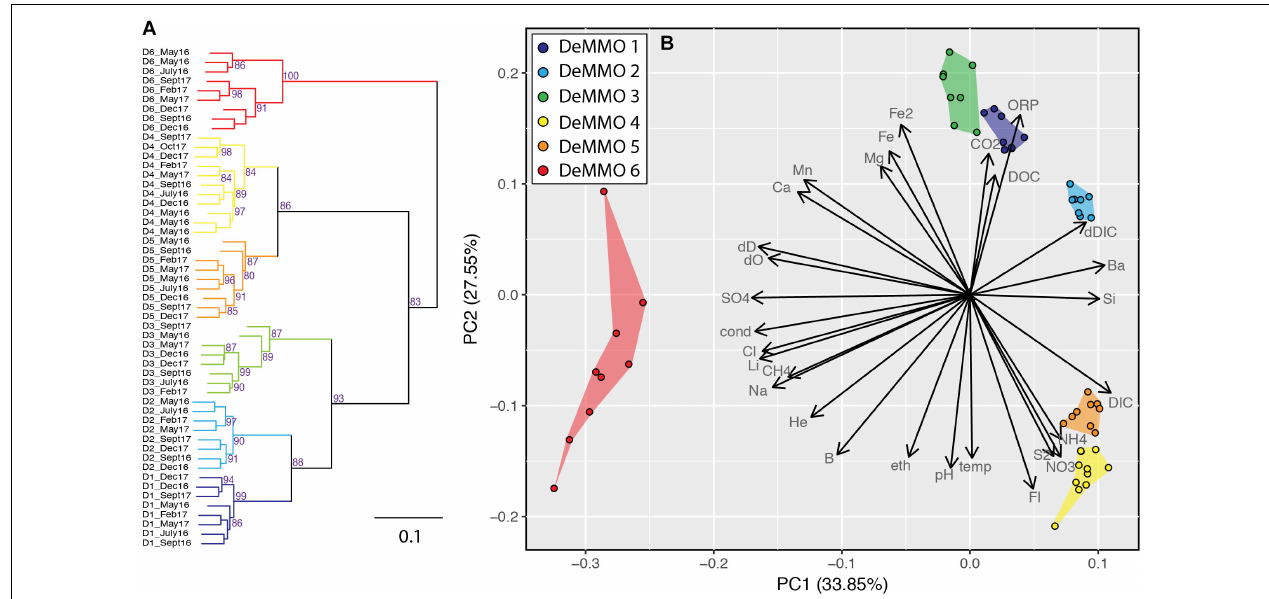
FIGURE 8 | Hierarchical clustering and PCA analysis of sites based on geochemistry inputs. (A) Wards Clustering and Euclidean distance matrix. Bootstrap values > 80 for higher order nodes shown in purple. (B) Principle components analysis produced in R with the prcomp() command and visualized using the ggfortify package. Envelopes containing all the points for a given site are highlighted for emphasis. Vectors illustrate the loading of different geochemical parameters on PC1 and